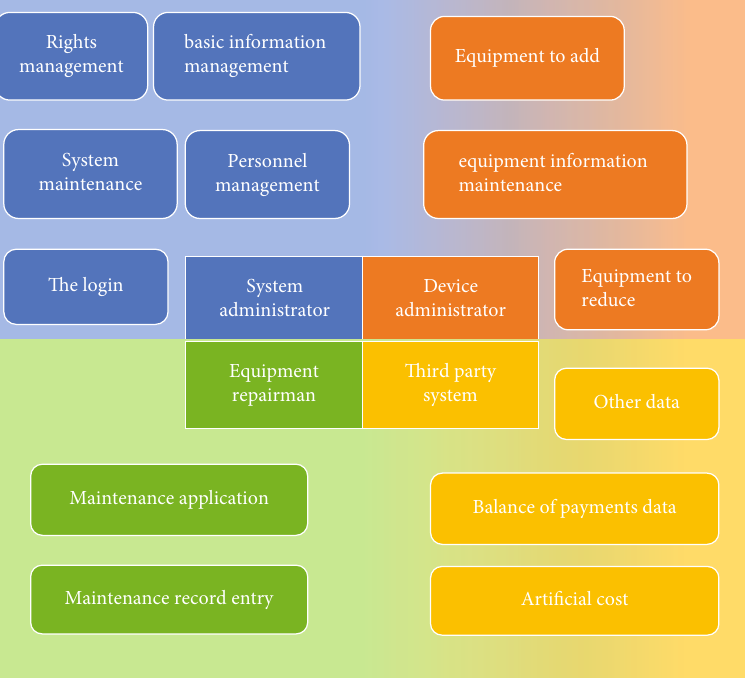
Figure 1: Case analysis model of full life